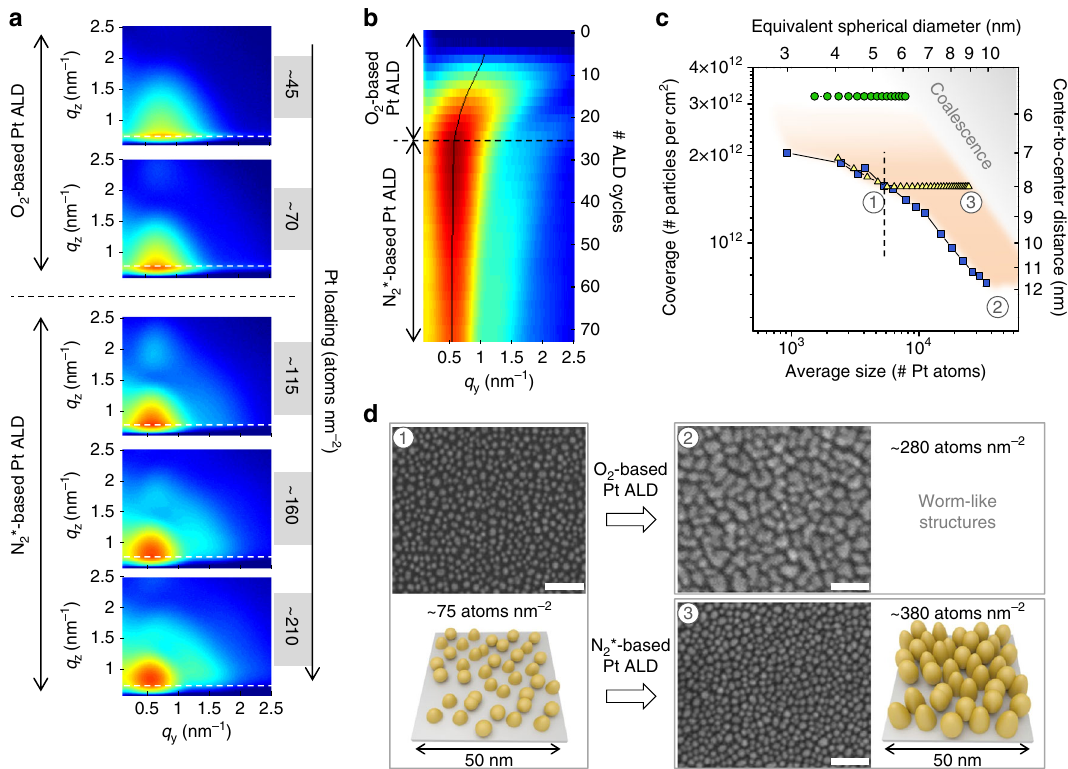
Fig. 5 In situ characterization of the morphological tuning of Pt nanoparticles during ALD. a Selection of 2D GISAXS images measured in situ during a combined process using fi rst 24 cycles of the O 2 -based Pt ALD process followed by N 2 * -based Pt ALD. b 2D color map showing the intensity evolution of the line pro fi les at the Si Yoneda position indicated by the dashed horizontal lines in a . c Average particle coverage against particle size for O 2 -based Pt ALD (blue squares), N 2 * -based Pt ALD (green circles), and the combined process using fi rst 24 cycles of the O 2 -based Pt ALD process (left side of the dashed line) to tune the particle coverage followed by N 2 * -based Pt ALD (right side of the dashed line) to tune the particle size (yellow triangles). d Representative SEM images and schematic representations of the GISAXS results after (1) 24 O 2 -based ALD cycles, (2) continued growth with the O 2 -based ALD process, and (3) continued growth with the N 2 * -based ALD process. The white scale bars indicate 50